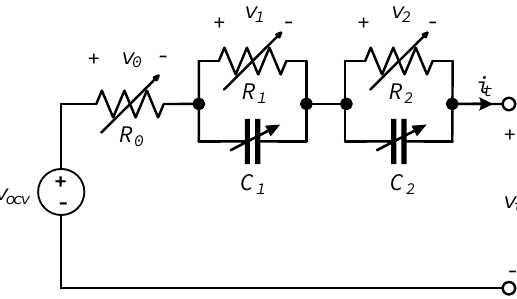
Figure 2. Second order Thévenin equivalent circuit used to represent li-ion polymer cell.